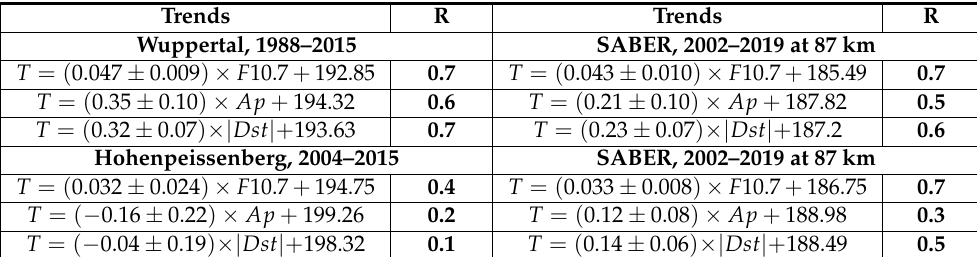
Table 2. Trends with correlation coefficient R obtained using the full ranges of ground-based and SABER temperature